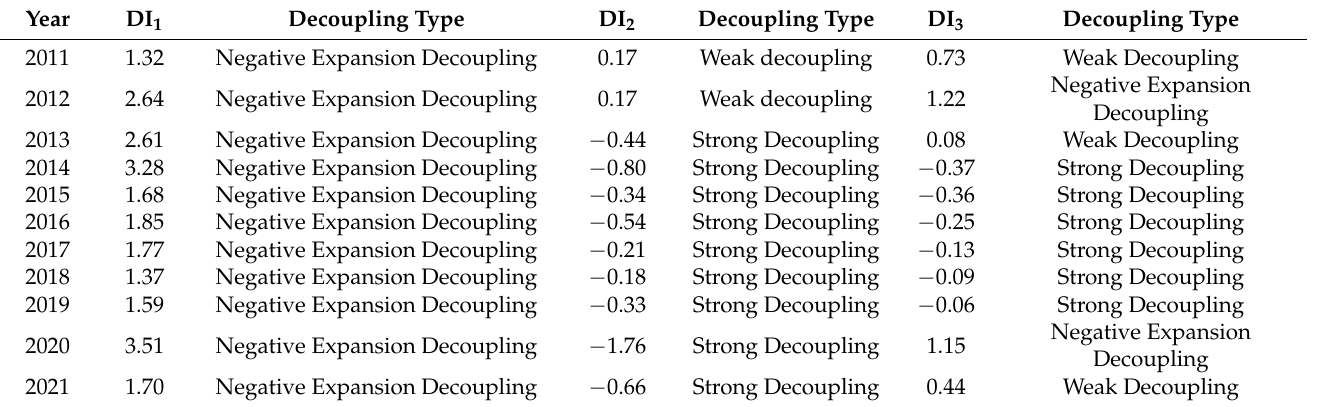
Table 6. Impact decoupling indicators of the mining industry in the Russian Federation for